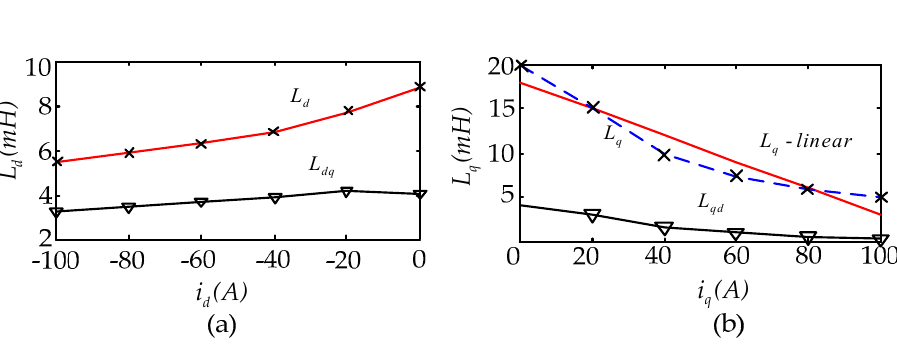
Figure 4. Nonlinear characteristic of stator inductance as a function of current. ( a ) d -axis inductance with d -axis current; ( b ) q -axis inductance with q -axis current.